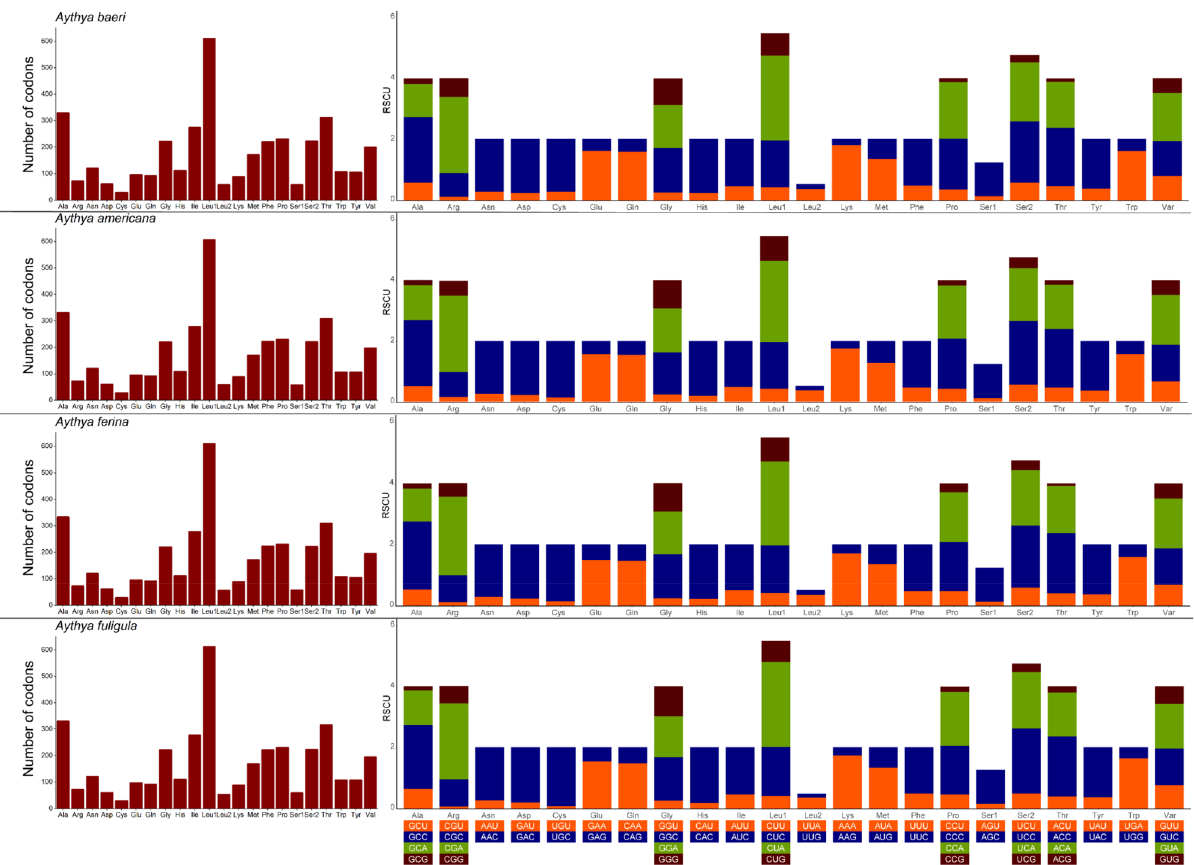
Figure 3. Codon distribution (left) and relative synonymous codon usage (right) in the mitochondrial protein- coding genes of four Aythya